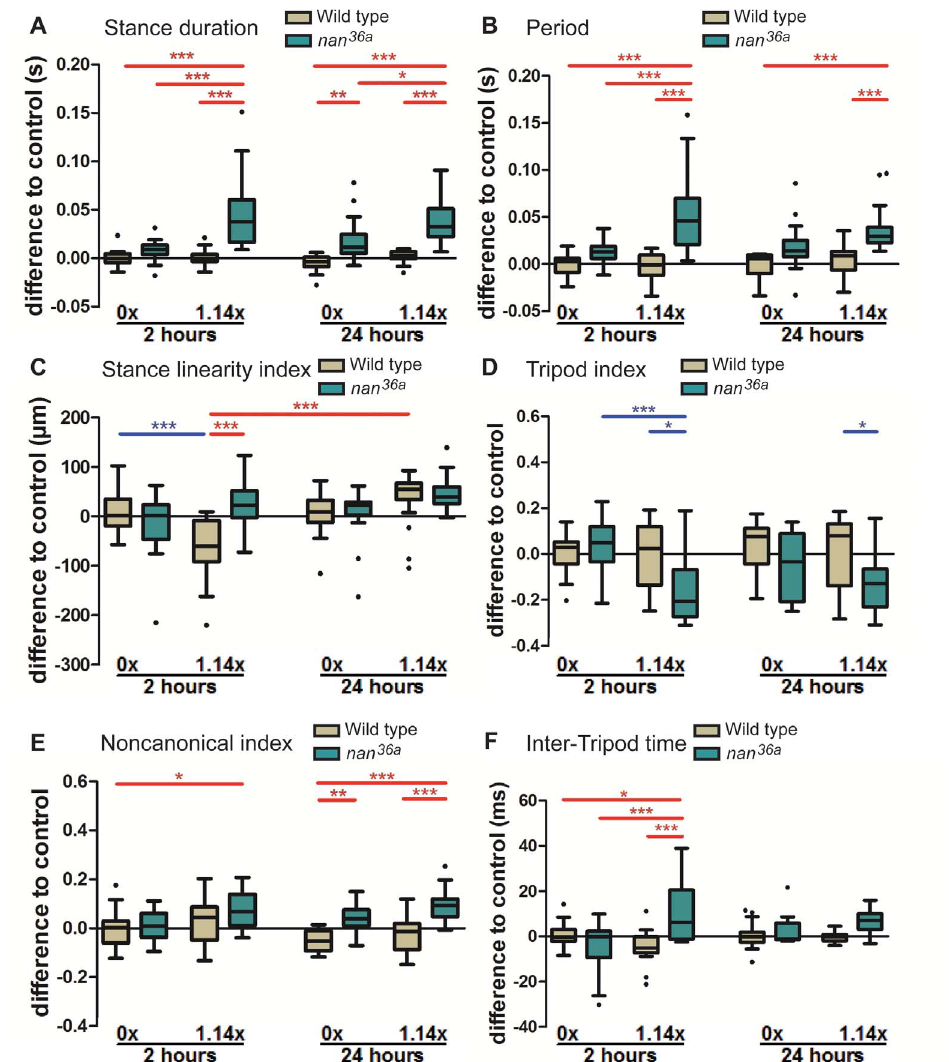
Figure 7. Effects of chordotonal organ deprivation while weight bearing. Box plots represent the median as the middle line, with the lower and upper edges of the boxes representing the 25% and 75% quartiles, respectively; the whiskers represent the range of the full data set, excluding outliers. Circles indicate outliers. Statistical significance was determined using 3-way-ANOVA with post-hoc t-tests, where * p , 0.05; ** p , 0.01; *** p , 0.001. Statistically significant increases or decreases are indicated in red and blue, respectively. (A) Stance Duration. Only weighted nan 36a flies show increased stance duration, and this effect occurs independently of time. (B) Step period only increases significantly for weighted nan 36a flies in a time- independent manner. (C) Stance linearity index. Animals carrying intermediate weights display a less wobbly stance phase 2 hours after weight bearing, this effect is absent in nan 36a flies. (D) Tripod index. Sensory deprived nan 36a flies display a significant reduction in the use of tripod configurations during weight bearing. (E) Non-canonical index. nan 36a flies weight bearing show an increase in non-canonical configurations in a time-independent way. (F) Inter-Tripod time. Weight bearing nan 36a flies display an increased transition time between tripod configurations. This effect is only visible after 2 hours of weight